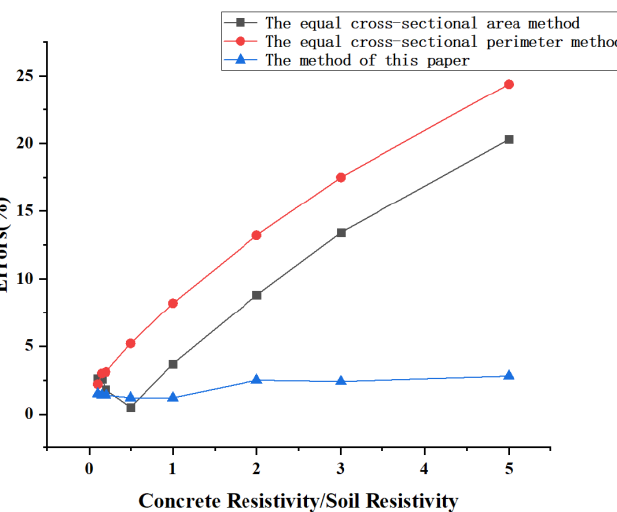
Figure 4. Errors for the power frequency grounding resistances of the three equivalent methods.